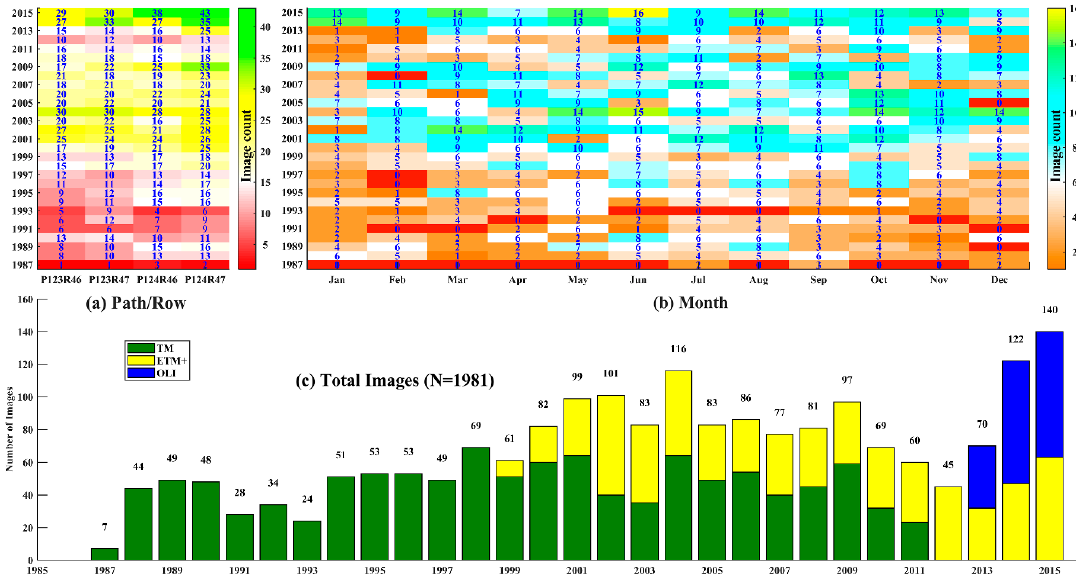
Figure 2. Statistical information of Landsat TM/ETM+/OLI imagery on Hainan Island during 1987 and 2015. Statistical data was conducted by ( a ) path/row; ( b ) month; and ( c )